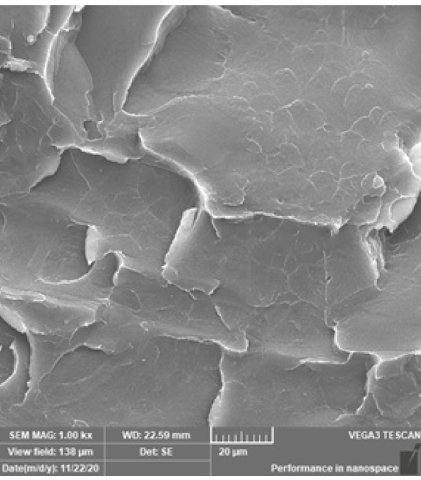
Figure 2: Representative SEM image for the control